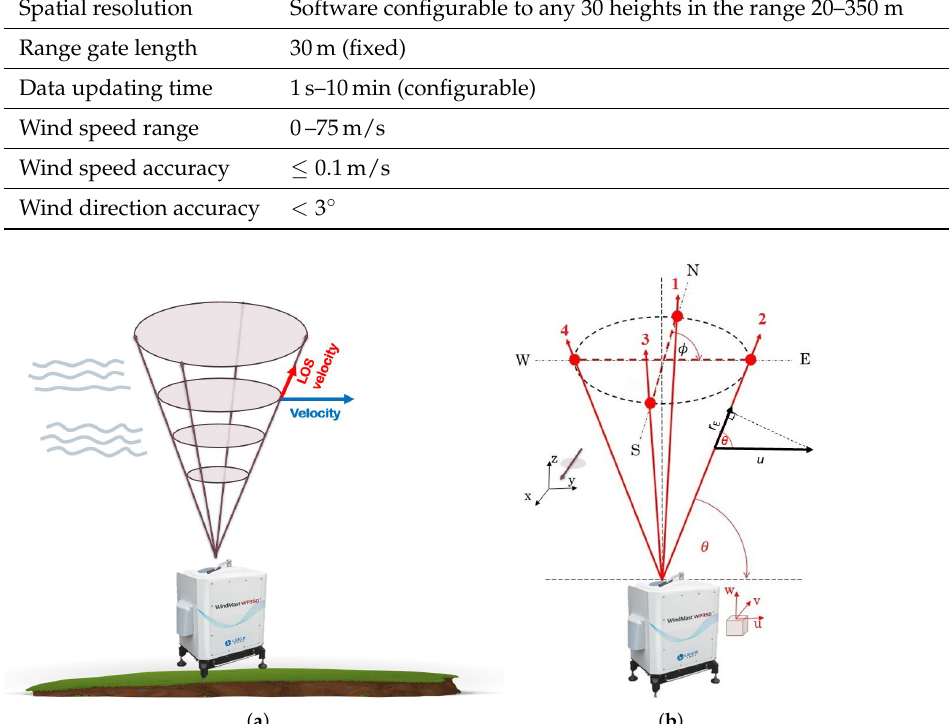
Figure 2. The schematic of Doppler beam swinging scan: ( a ) visualization of scanning circles at different heights; ( b ) visualization of the four laser beams configuration of the lidar with relevant angles and two coordinate systems, one used by lidar and one used for wind analysis. For better visibility, just the component of radial velocity in the laser beam 2 direction ( r E ) and component of wind vector u in the lidar coordinate system are